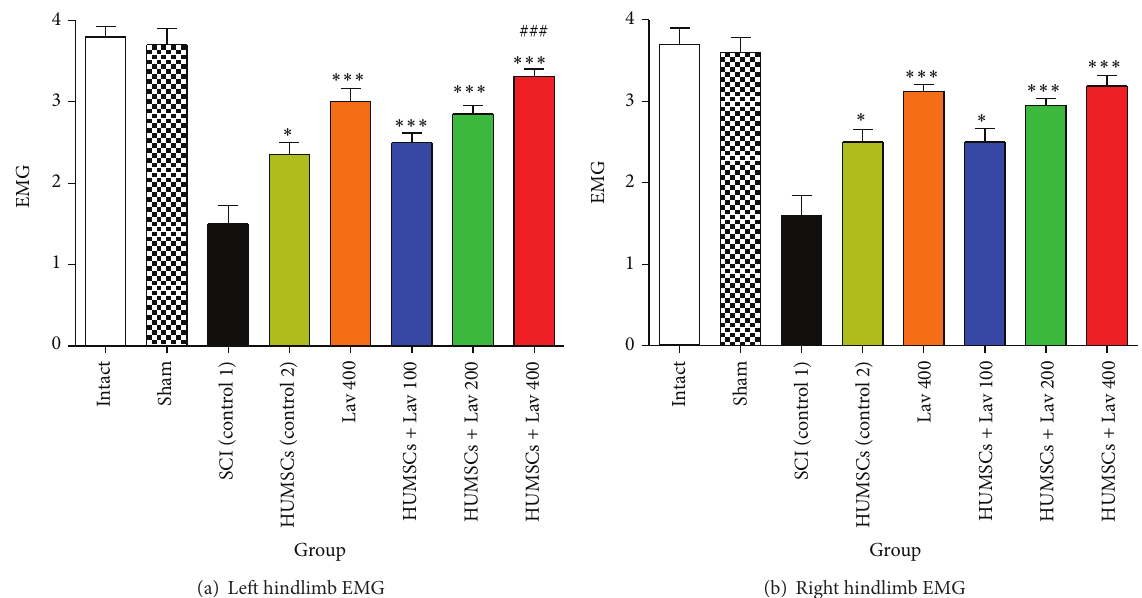
Figure 2: Stem cell therapy and administration of L. angustifolia improved locomotor and EMG impairment in the rat spinal cord contusion model. Intraperitoneal administration of L. angustifolia extract daily for 14 consecutive days after injury significantly improved the EMG results in left (a) and right hindlimbs (b) in HUMSCs treated groups. Data are represented as mean ± SEM. (a) ∗ and ∗∗∗ show significant differences between HUMSCs + Lav 100, 200, and 400 compared to the SCI group (control 1) ( 𝑃 < 0.05 and 𝑃 < 0.0001 , resp.). ### shows significant differences between HUMSCs + Lav 400 (control 2) and HUMSCs ( 𝑃 < 0.0001 ). (b) ∗ and ∗∗∗ show significant differences between HUMSCs + Lav 100, 200, and 400 compared to the SCI group (control 1) ( 𝑃 < 0.01 and 𝑃 < 0.0001 ,